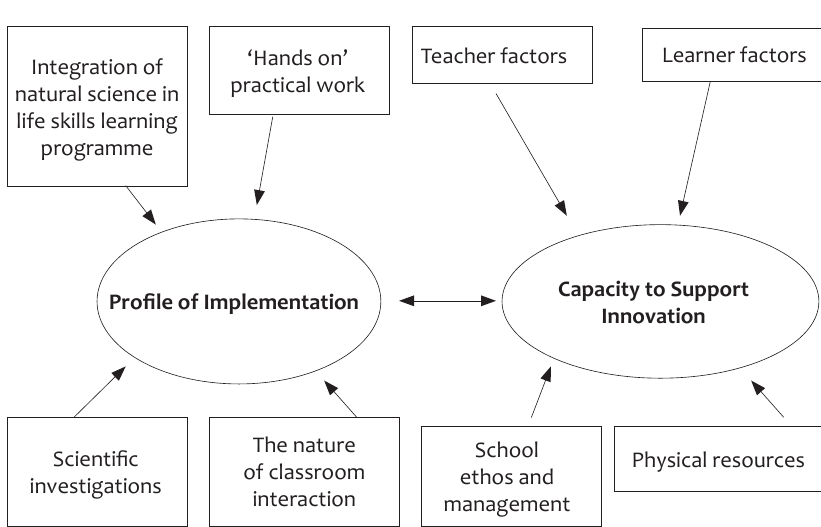
Figure 2: The framework for the study (Rogan, 2007: